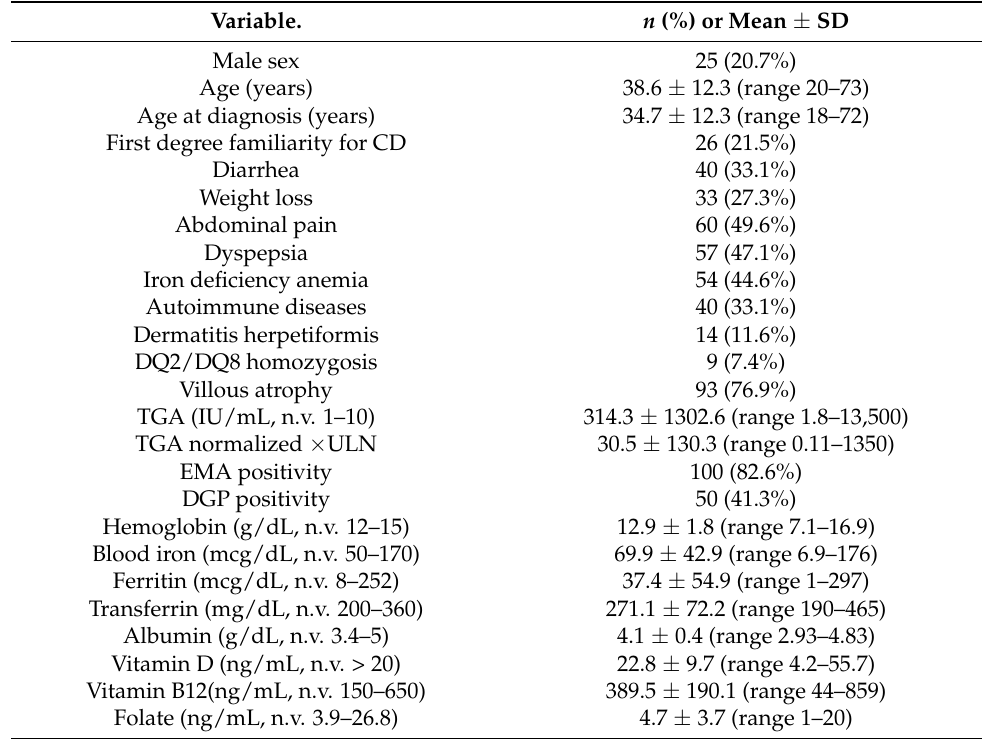
Table 1. Main features regarding enrolled population, including demographic data, clinical symp- toms, serologic profile, and laboratory